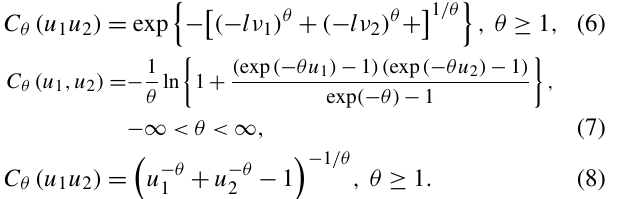
Table 1. Bivariate copula, parameter vectors, and Kendall’s τ